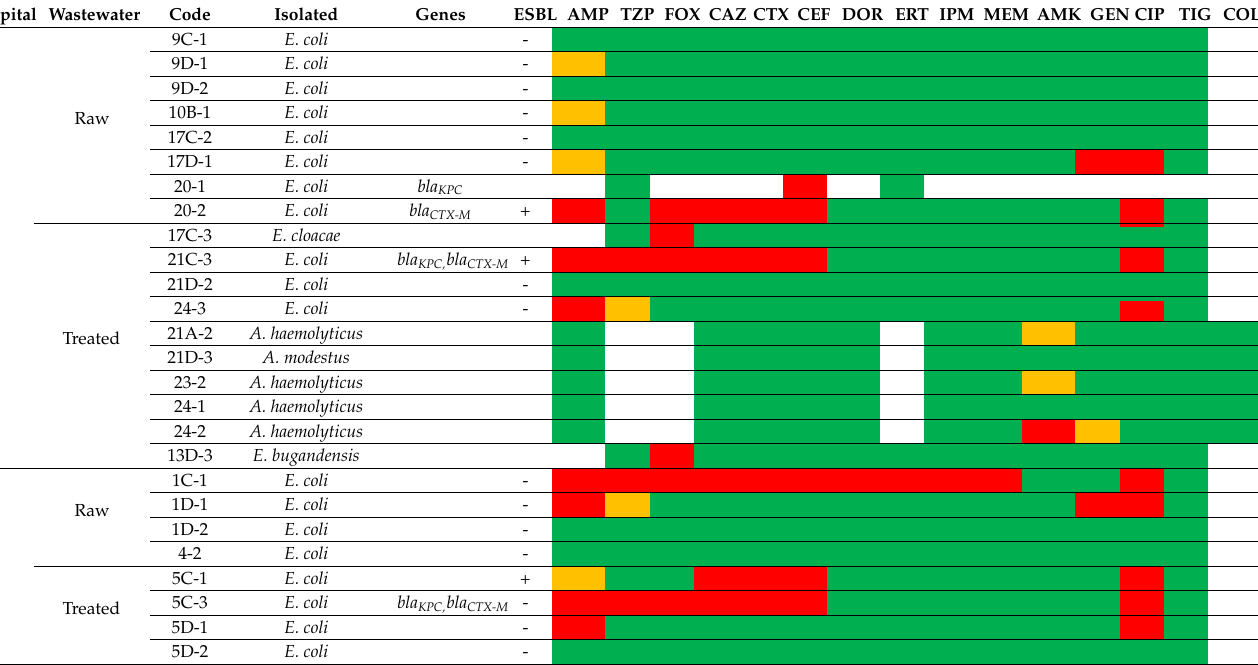
Table 1. Phenotyping properties of E. coli , Acinetobacter spp. and Enterobacter spp. isolated from the hospital wastewater treatment plants